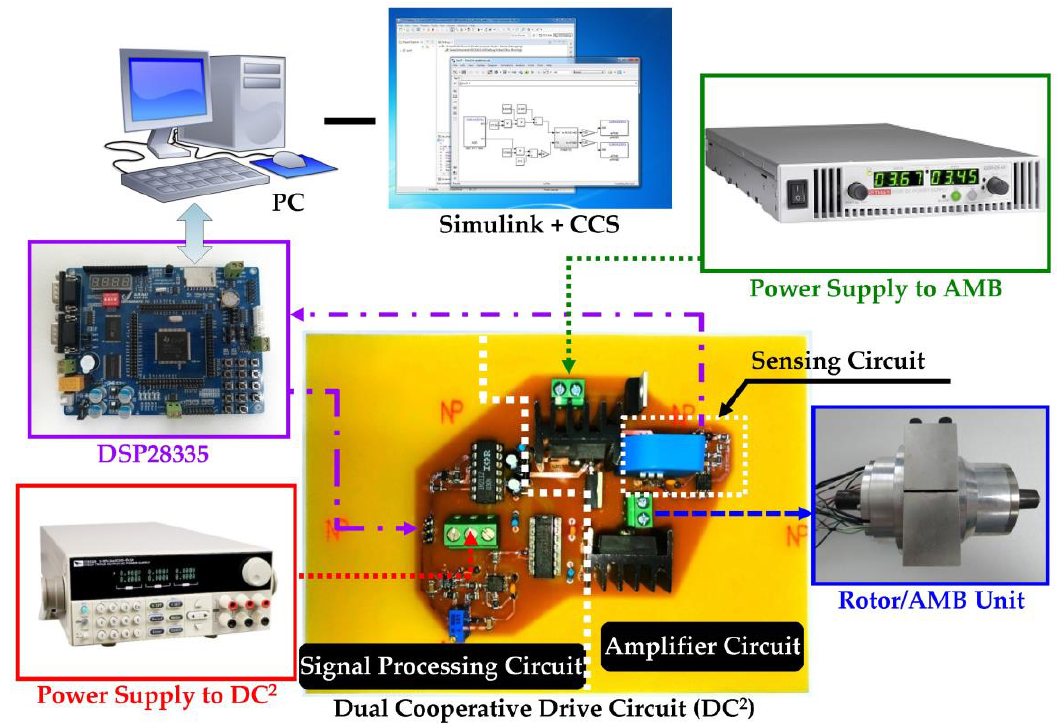
Figure 14. Schematic diagram of equipped facilities to conduct experiments.